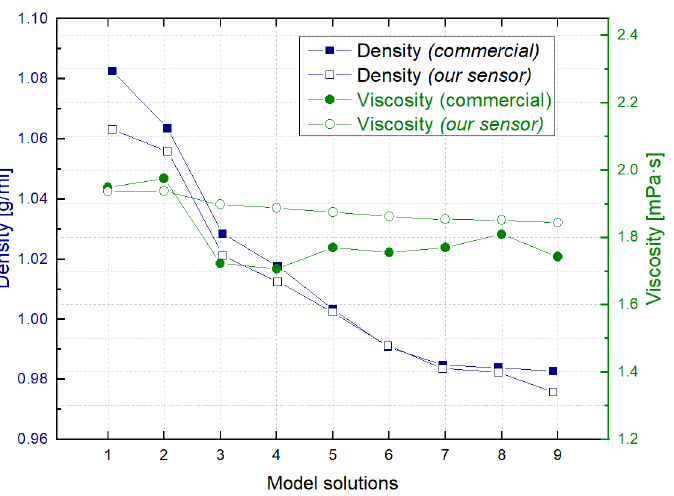
Figure 14. Density and viscosity values measured with the commercial density-viscosity meter and with our sensor cell for the model solutions.